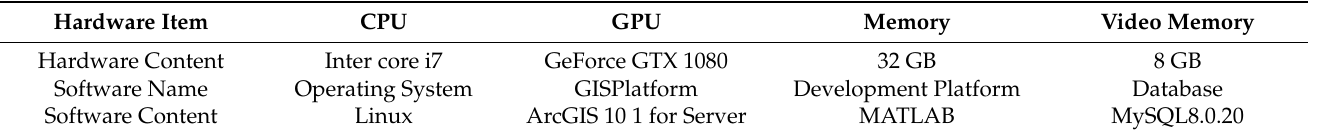
Table 1. Development environment.